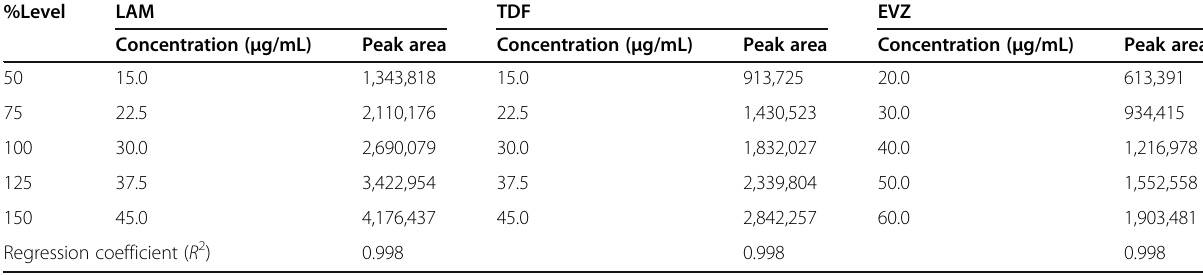
Table 3 Concentration and peak areas of linearity level solution of LAMI, TDF, and EVZ %Level